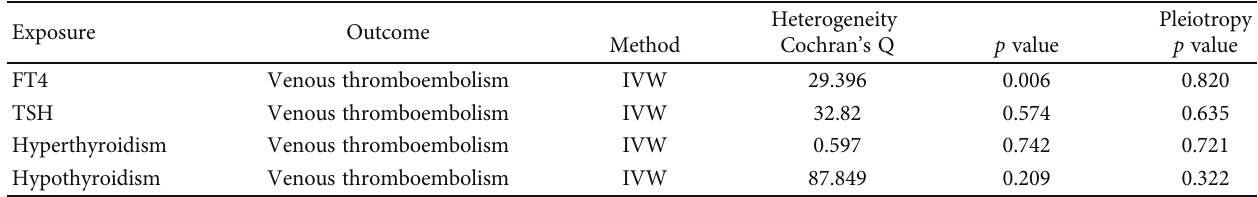
Table 7: Heterogeneity and pleiotropy test